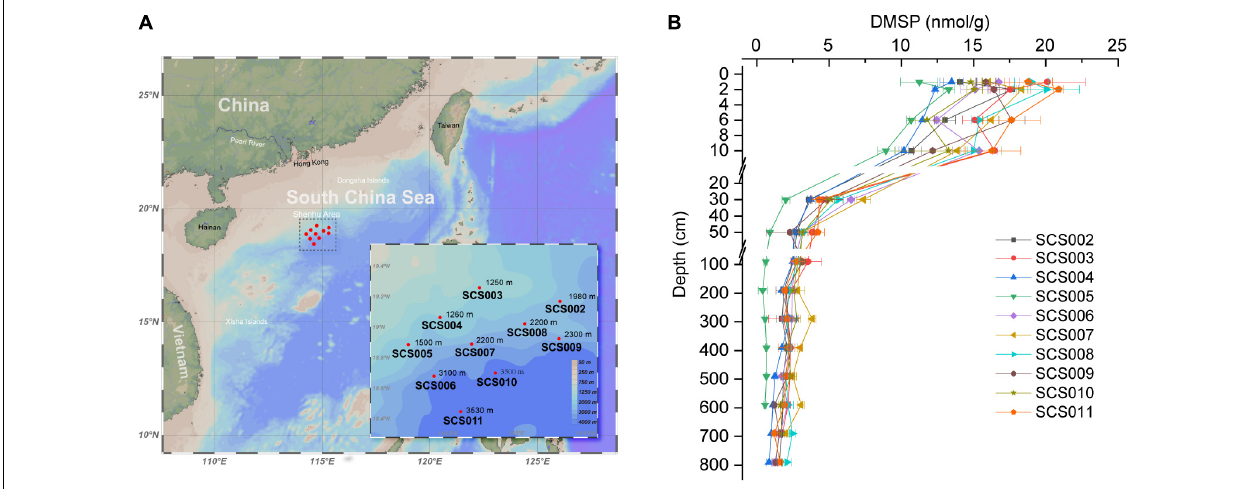
FIGURE 1 | Sitemap (A) and DMSP concentrations in the SCS sediments (B) . Seafloor depth are indicated in each site. Data are presented as means ±